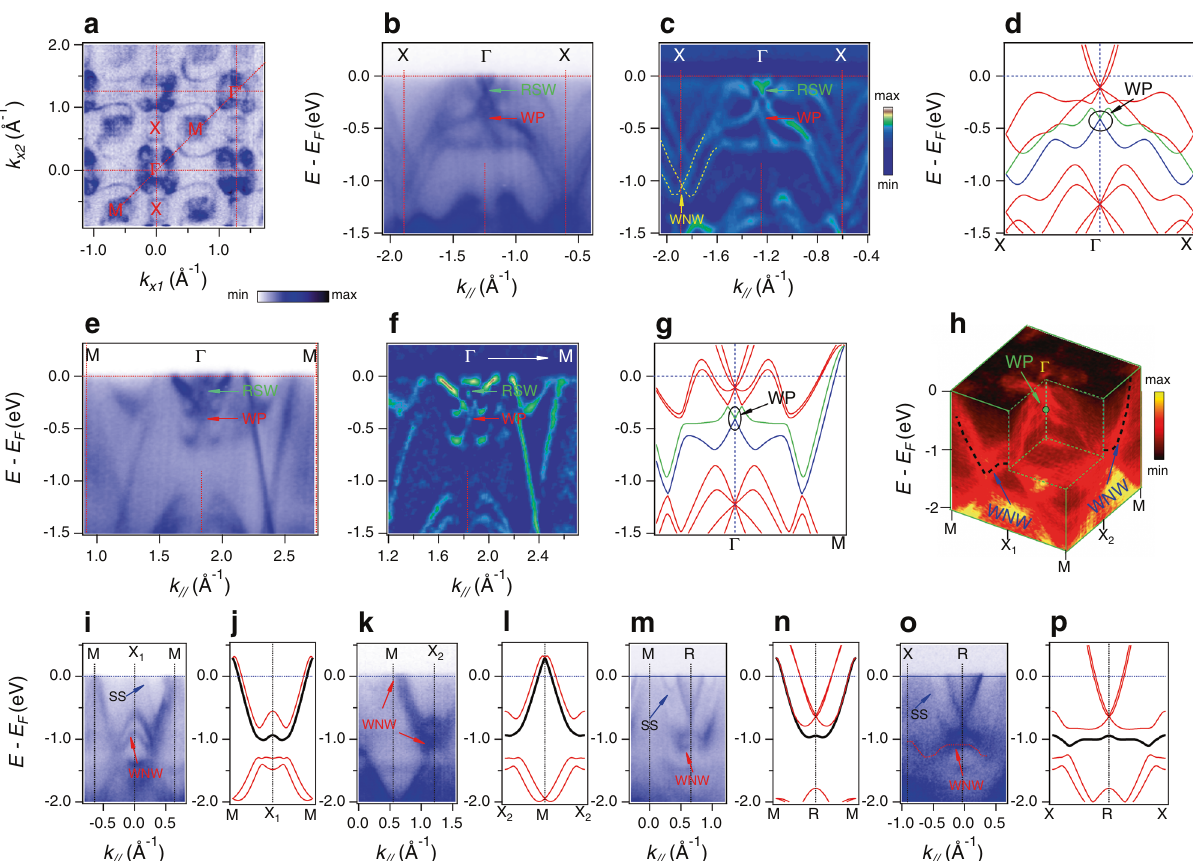
Fig. 2 Electronic structure of PtGa along the high-symmetry lines showing an singular WP at the center of the BZ surrounded by WNWs on the BZ boundaries. a FS map in the Γ – X – M plane, acquired with hv = 605 eV at 12 K. b , c High-resolution ARPES spectra along the Γ – X line and the related curvature intensity plot. The red arrows indicate the WP (Weyl point) at the Γ point. d Calculated band dispersion along the X – Γ – X line. The singular WP at the Γ point is highlighted by the circle. e , f The high-resolution ARPES spectra along the Γ – M direction and the related curvature intensity plot. The red arrows indicate the singular WP in the center of the BZ. g The calculated band dispersion along the M – Γ – M direction. The singular WP at the Γ point is highlighted by the ellipse. h 3D intensity plot of the electronic structure in the Γ – X – M plane; the singular WP at the Γ point and the WNWs (Weyl nodal walls) on the BZ boundary are marked with the fi lled green circle and black dotted lines, respectively. i – p The ARPES spectra and the related calculated band dispersions along high-symmetry lines on the BZ boundaries are displayed alternately. The black dispersive curves represent the WNWs. “ SS ” denotes surface